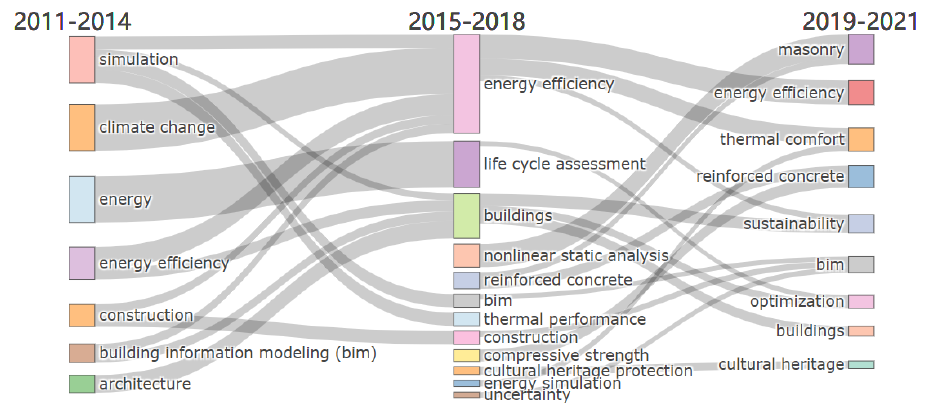
Figure 7. Thematic evolution.